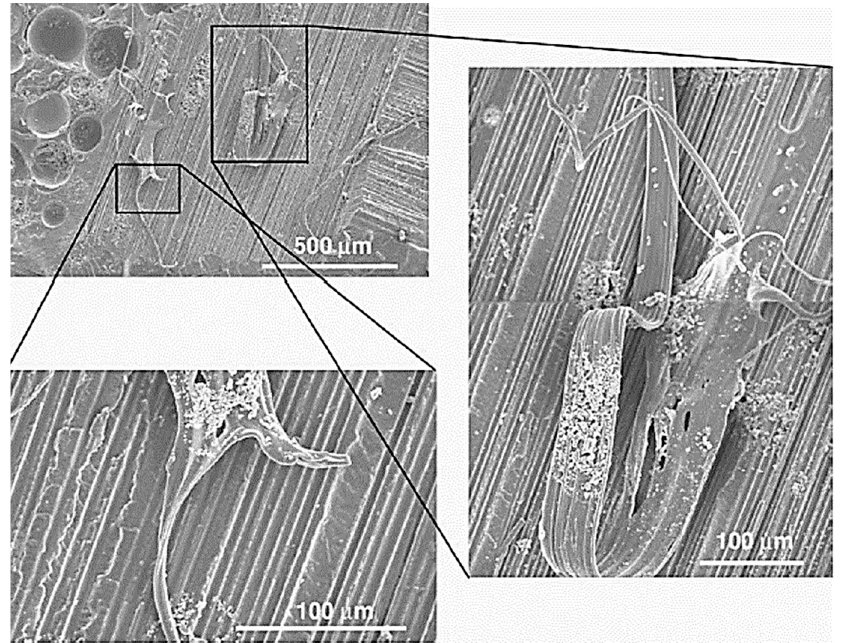
Figure 11. Scanning electron microscopy images of healed fracture surfaces of self-healing sample (30 min healing time). Reprinted with permission from [130]. 2003, Elsevier.